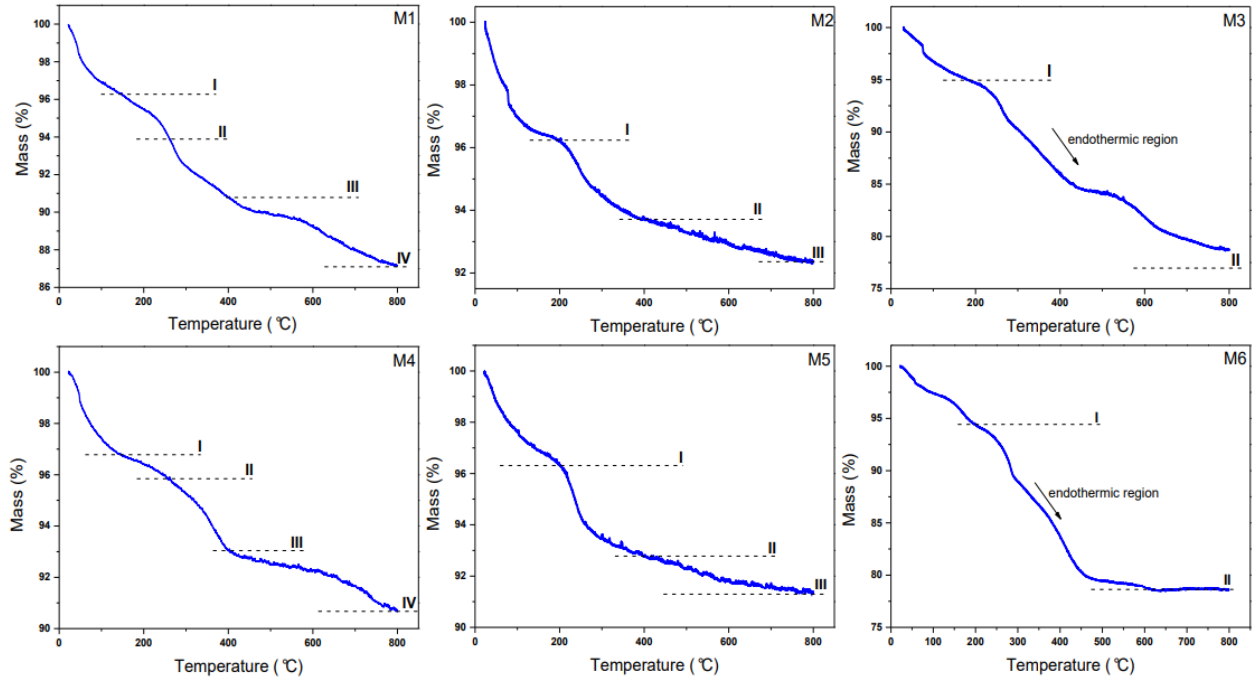
Figure 5. TG curves obtained from RT up to 800 °C for the M1-M6 samples. The steps described in the text are defined in each TG curve.